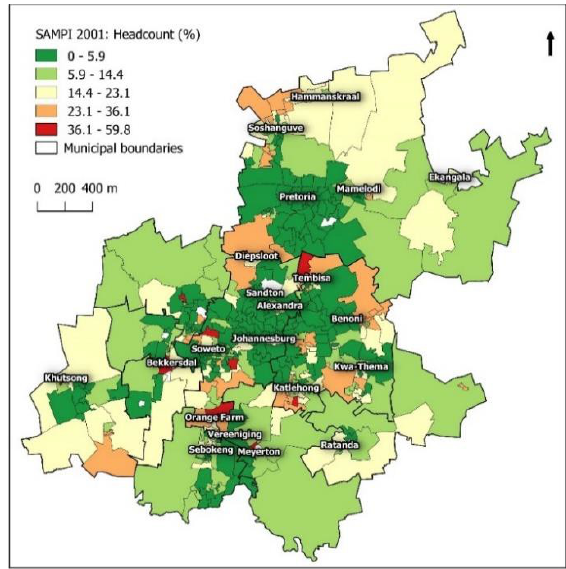
Figure 3. Poverty headcount (%) in